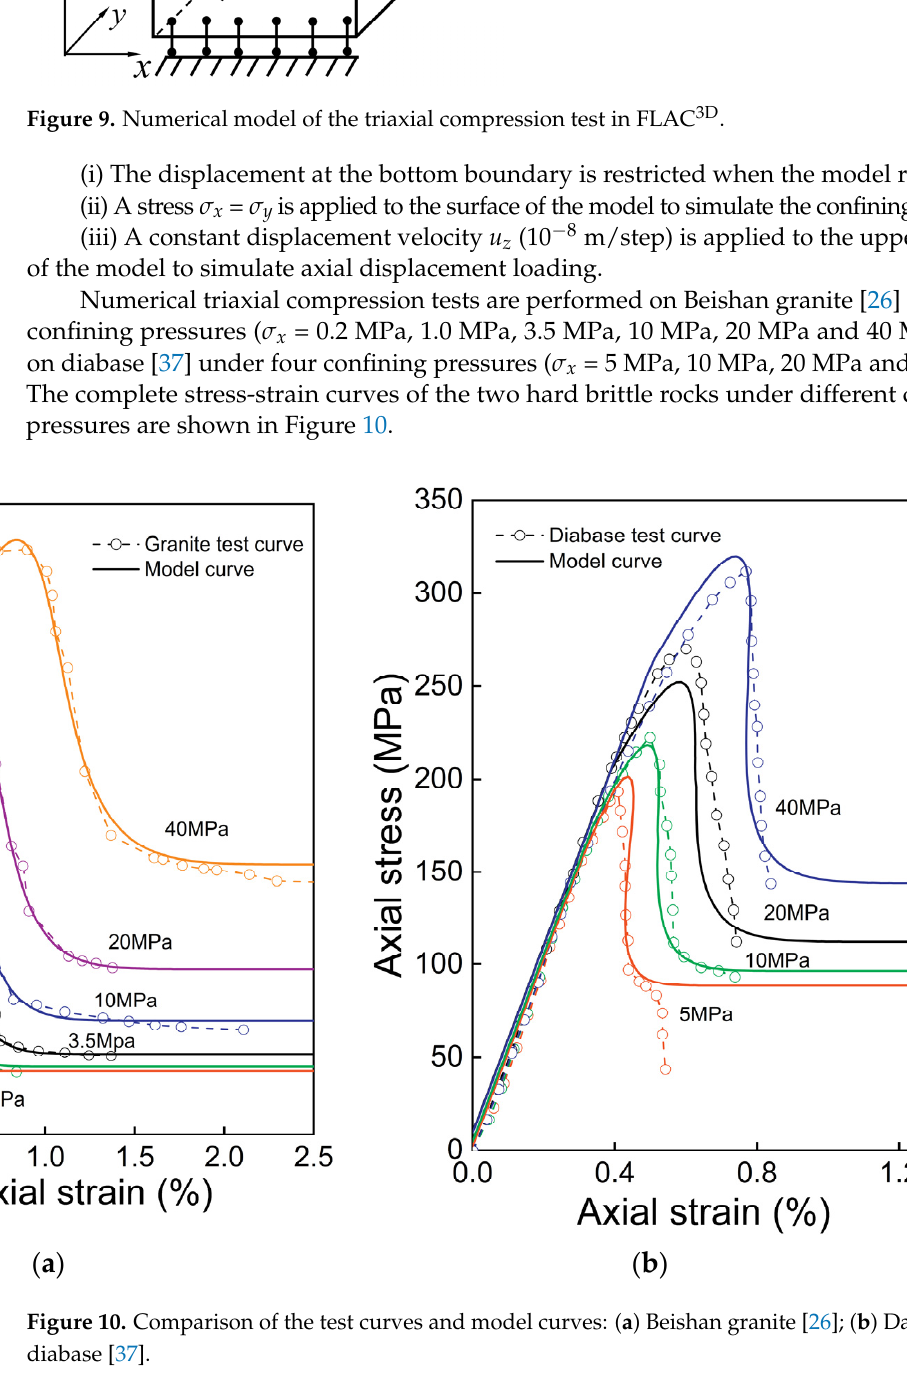
Figure 10. Comparison of the test curves and model curves: ( a ) Beishan granite [26]; ( b ) Danjiangkou diabase [37].